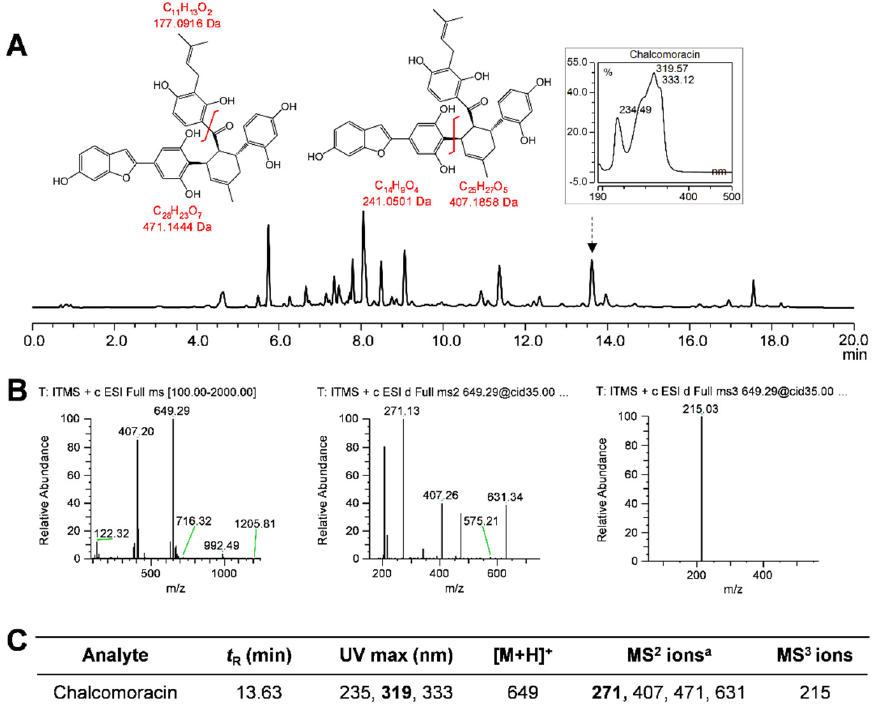
Figure 9. Characterization of chalcomoracin. ( A ) HPLC chromatogram (UV 320 nm) of ethyl acetate extract of the medium of white mulberry hairy root line U − D2. Chemical structure of chalcomoracin and proposed fragmentation pattern of peak identified as chalcomoracin are shown. ( B ) HPLC − PDA − ESI − MS 3 analysis of chalcomoracin. ( C ) HPLC − PDA − MS 3 fragmentation pattern of chalcomoracin. a, MS 2 ions in boldface were the most abundant ions and were subjected to MS 3 fragmentation.